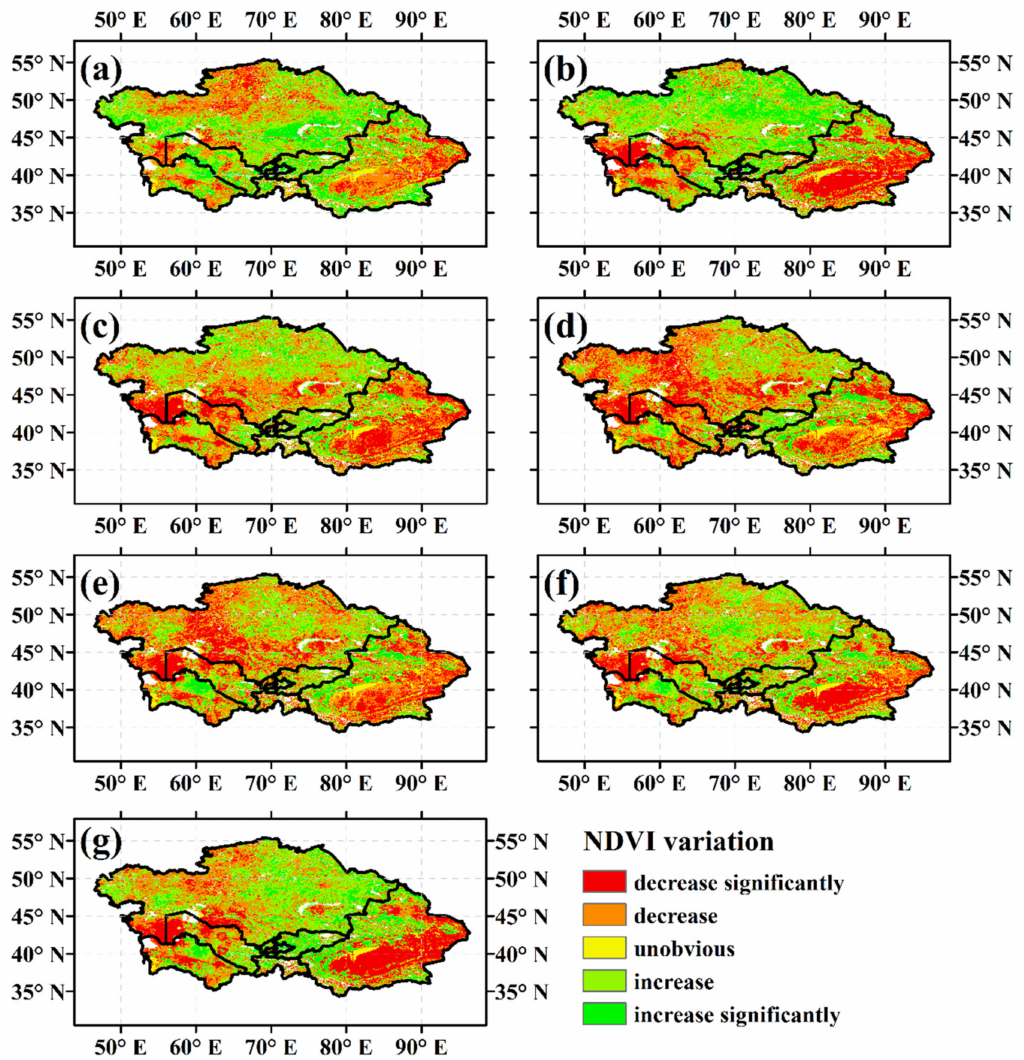
Figure 5. NDVI variation during 1982–2015 in April ( a ), May ( b ), June( c ), July ( d ), August ( e ), September ( f ), and growing season ( g